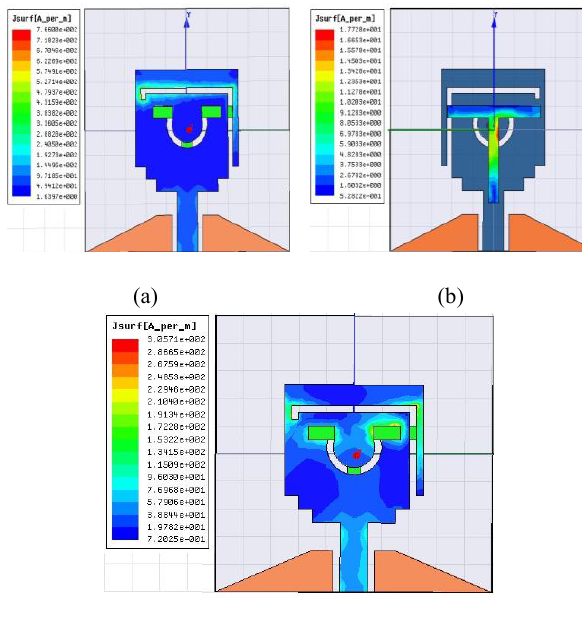
Figure 12: Simulated surface current distribution of the proposed antenna at (a) 3.3 GHz, (b) 5.6 GHz and (c) 8 GHz.